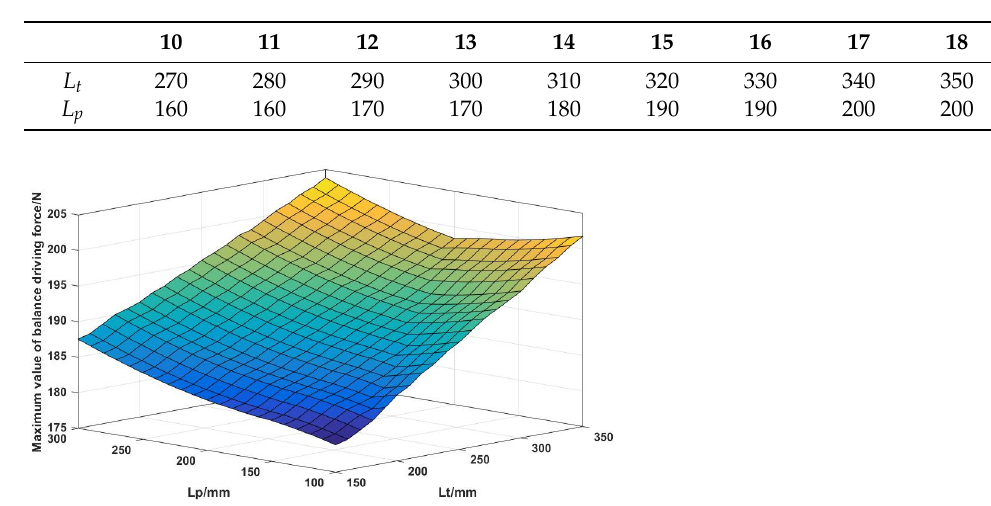
structure is shown in Figure 10.